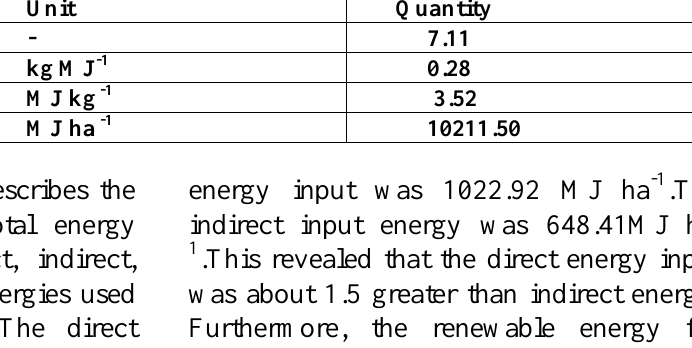
Table 5. Some energy indices for sunflower production in the mechanized rainfed schemes in eastern Sudan Inputs Unit Quantity Energy use efficiency - Energy